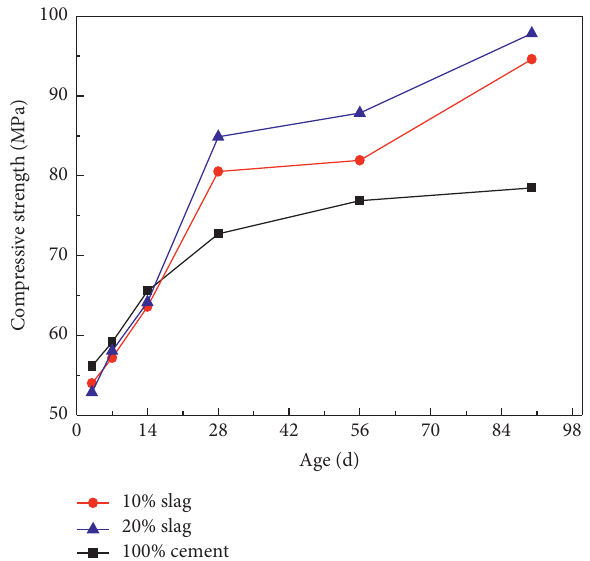
Figure 13: Effect of PCE-2 and fly ash dosage on compressive strength of cement